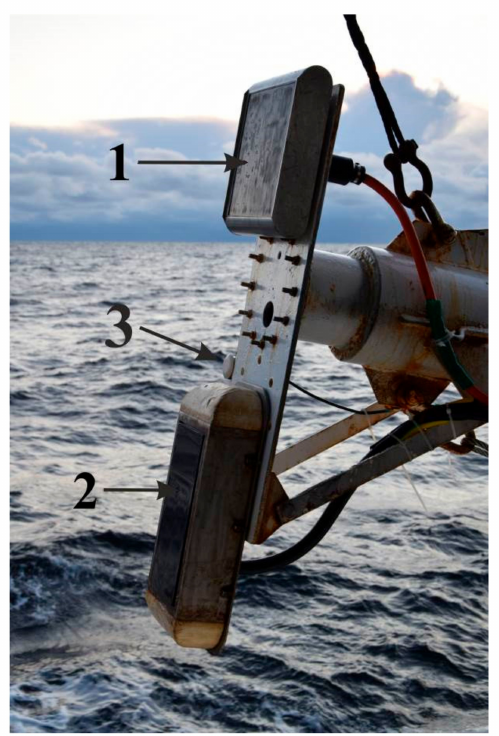
Figure 1. The pipe with echo sounders and SBP transducers in the marching position. 1—SES-2000 transducer, 2—WASSP WMB-3250, 3—Simrad EK-15 transducer (adopted from [10]).